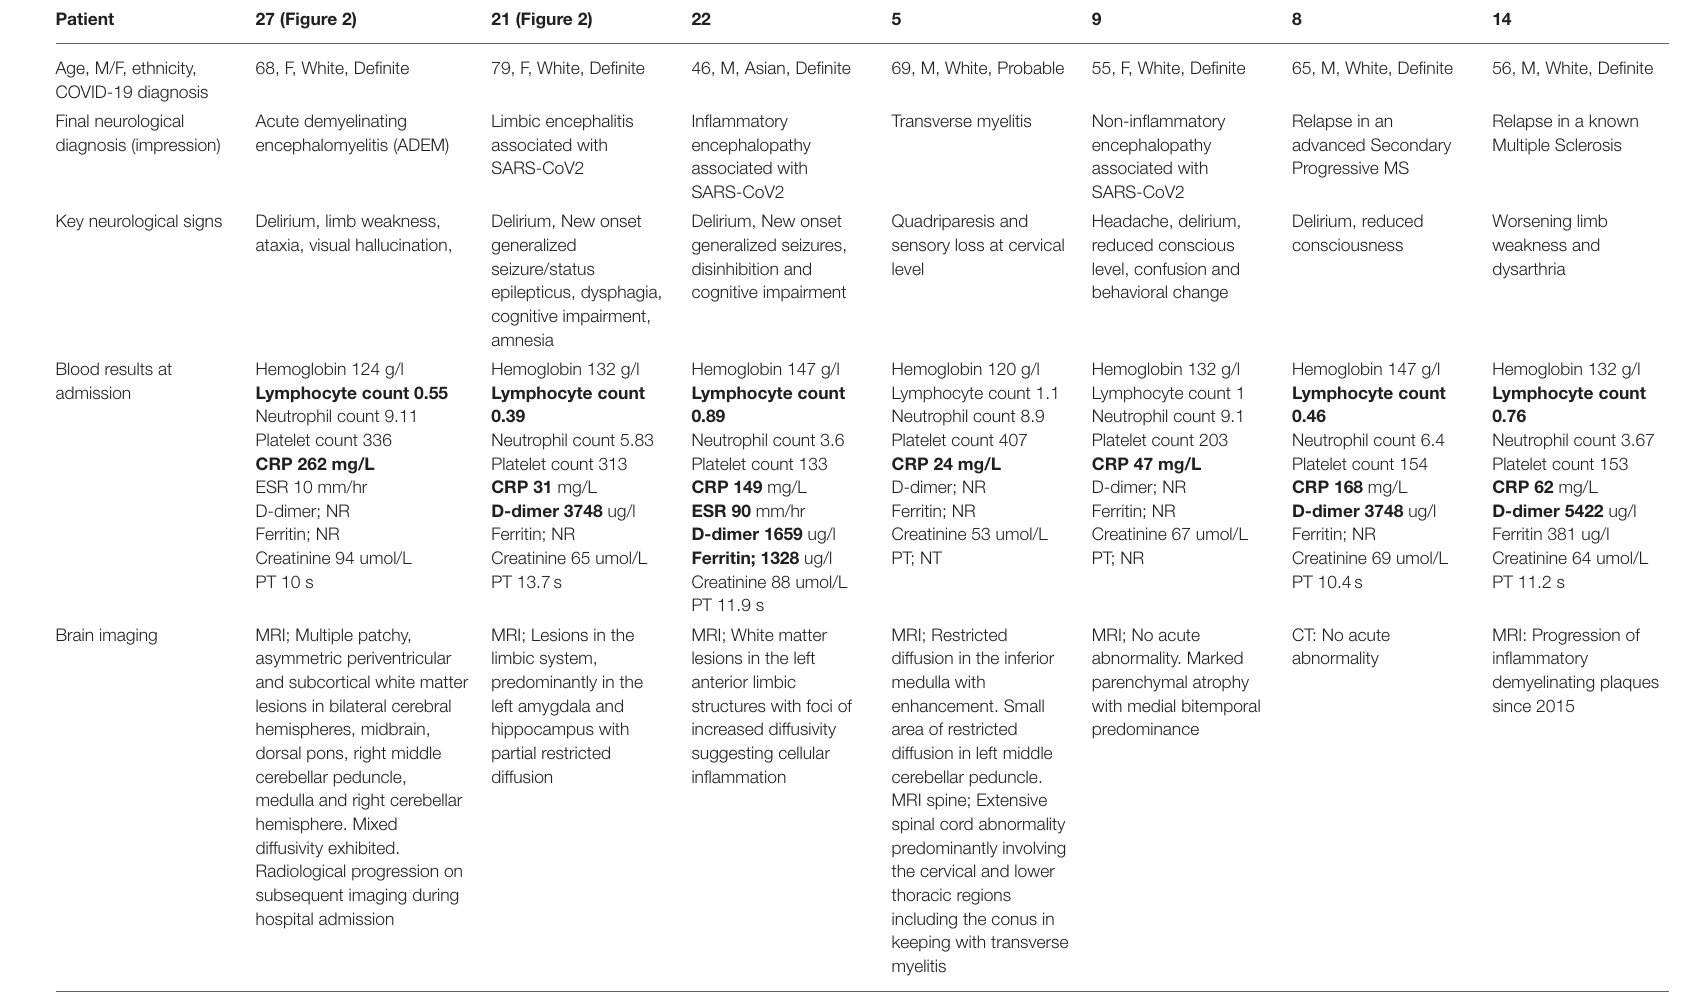
TABLE 2 | Seven patients with inflammatory, non-inflammatory or autoimmune encephalopathy, including two patients with known multiple sclerosis (MS), and one patient with transverse myelitis.